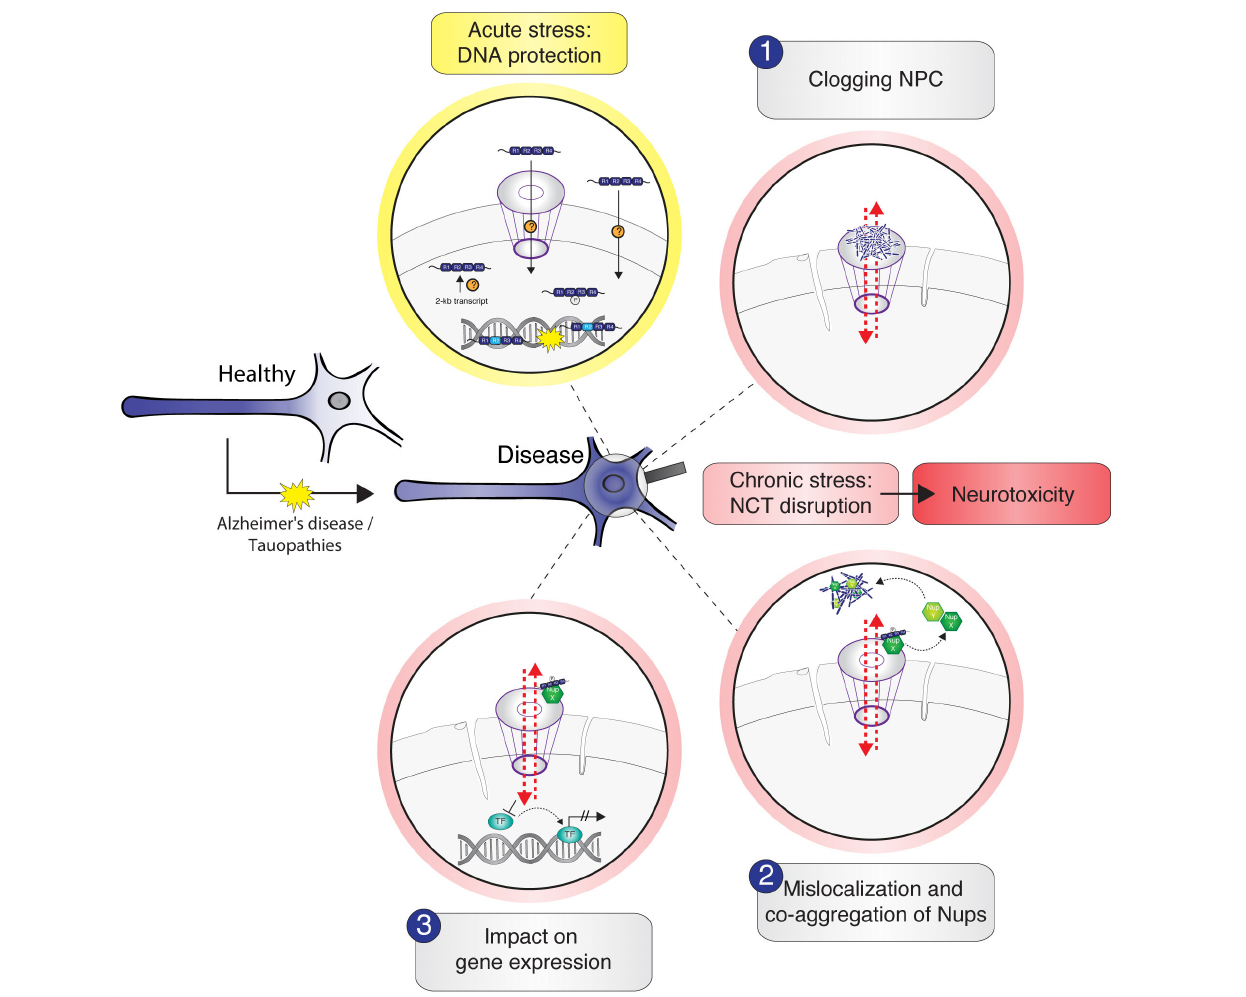
FIGURE 2 | Schematic illustration of potential tau–nucleus interactions leading to nucleocytoplasmic transport (NCT) impairment in tau-related neurodegeneration. Under physiological conditions, cytosolic soluble tau is mainly localized to the neuronal axon to stabilize the microtubules. In stress conditions and in the context of neurodegenerative diseases like Alzheimer’s disease and tauopathies, tau mislocalizes from the axon into the somatodendritic compartment where it gets in close proximity to the nucleus. Acute stress, for example, via heat shock, transiently increases the amount of intranuclear tau, either by active transport of tau through the nuclear pore complexes (NPC) or other unknown import mechanisms or by the enhanced expression and/or local translation of nuclear tau transcripts. Nuclear tau binds and stabilizes DNA during the time of insult, undertaking a DNA-protective role. Under persistent stress—as in the context of neurodegenerative diseases—the amount of hyperphosphorylated tau in the soma increases further and leads to different possible scenarios of tau-induced NCT disruption, which are accompanied with nuclear envelope abnormalities (e.g., invaginations) and result in neurotoxicity: (1) soluble and/or aggregated tau binds and thereby clogs the nuclear pore, resulting in cargo transport inhibition; (2) tau interacts with specific Nups of the NPC, leading to NPC disassembly and sequestration of Nups from the NPC into the cytosol, resulting in nuclear pore leakiness and co-aggregation of cytoplasmic Nups with tau; (3) somatodendritic tau interacts with Nups that under physiological conditions would associate with transcription factors to regulate gene expression. These interactions “distract” Nups and thereby indirectly affect gene